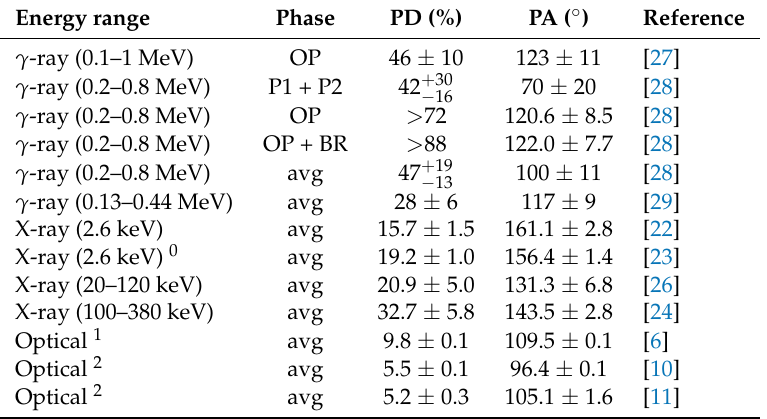
Table 1. Summary of representative multi-wavelength polarization measurements of the Crab pulsar plus nebula, unless otherwise indicated. Columns report the energy range, the phase interval where the polarization has been computed, the polarization degree (PD) and position angle (PA). The last column reports the reference publication. OP, off-pulse; P1, Peak 1; BR,